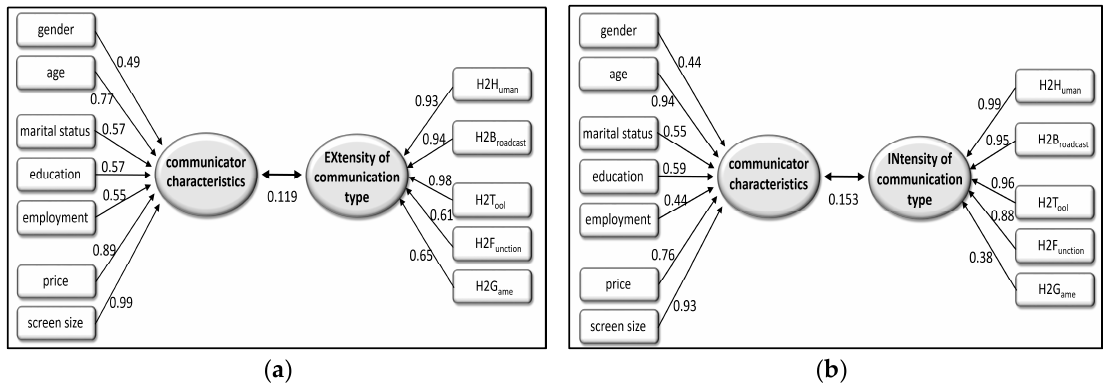
Figure 2. Canonical correlation analysis model for ( a ) extensity, and ( b ) intensity.